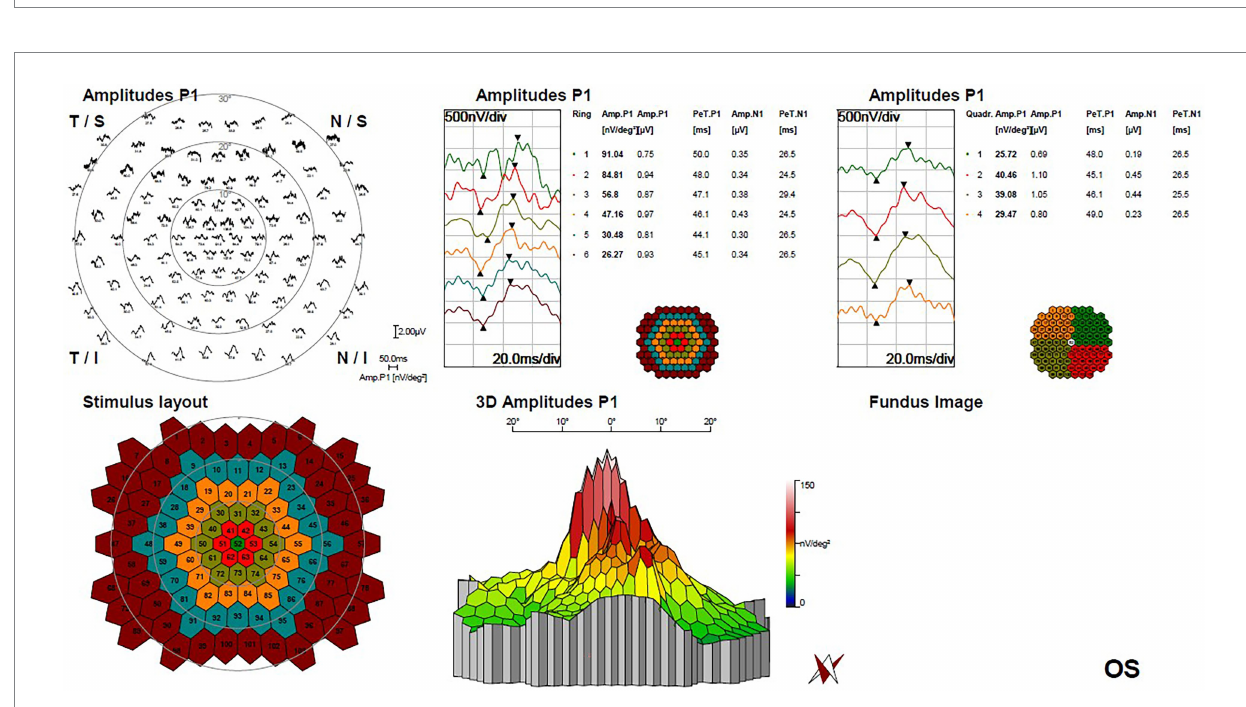
FIGURE 4 Multifocal electroretinogram of left eye demonstrated a significant focal amplitude decrease, especially in the temporal portion of macula